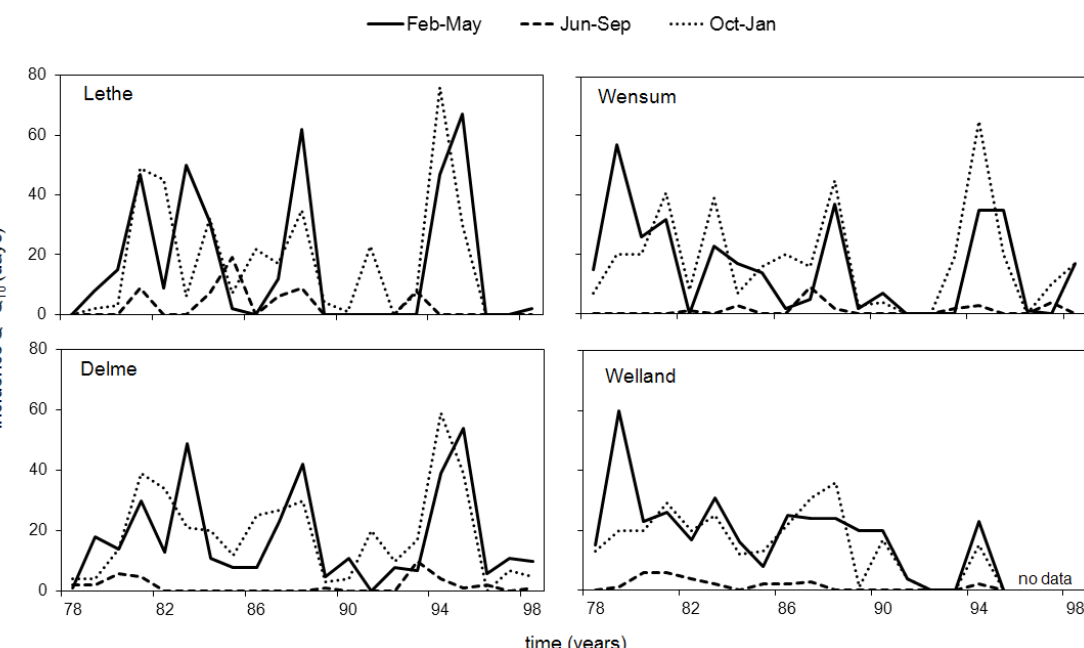
Figure A2. Annual changes in high flow (>Q ) incidence prior (February–May), during 10 (June–September) and after (October–January) the vegetation growth period for the German and English rivers (note no data available for Welland